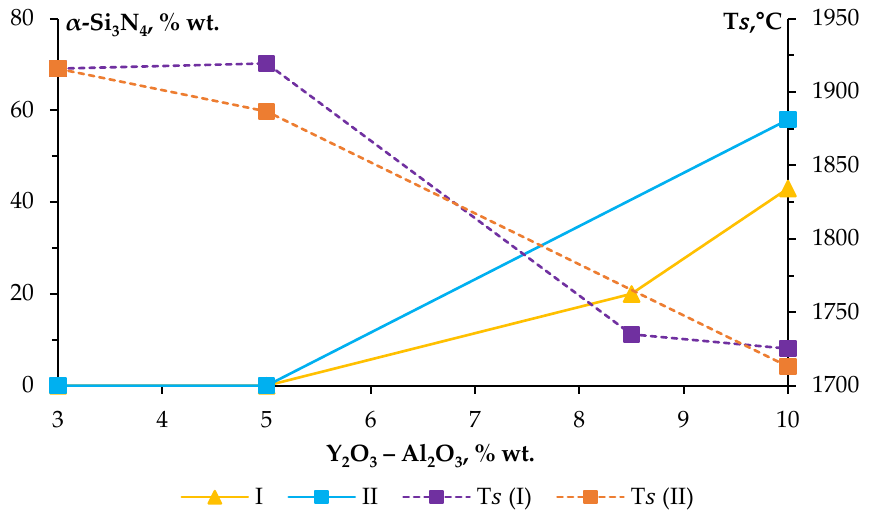
Figure 8. Dependence of the α -Si 3 N 4 amount in the ceramic sample and the sintering temperature on the sintering additive amount.